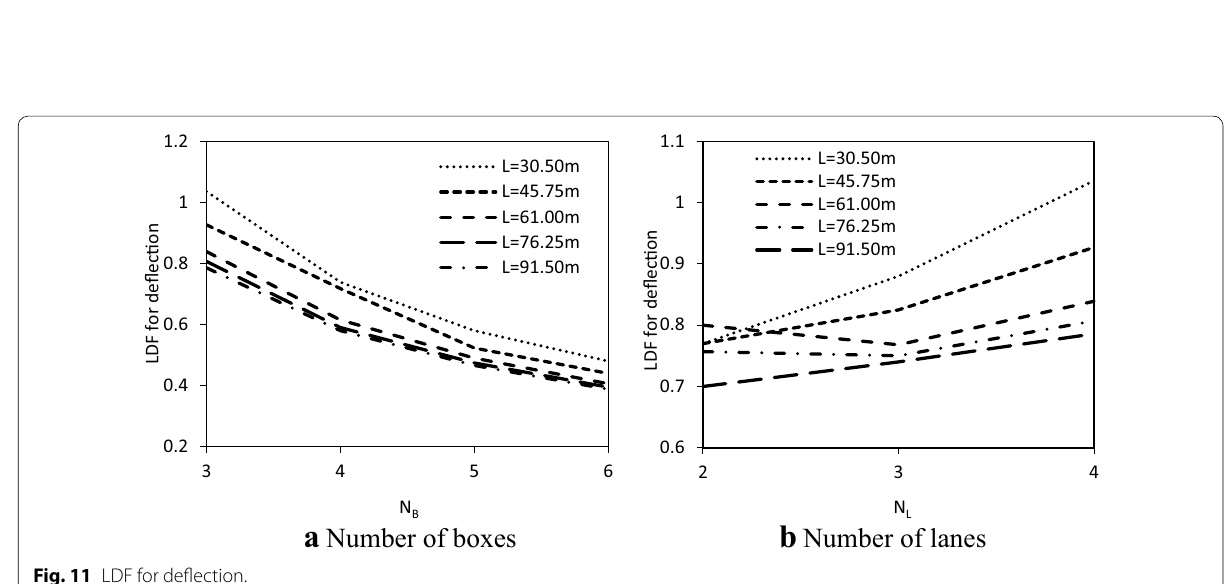
8 Empirical Formulae for the Stresses and the Deflection Samaan et al. (2002a) obtained the following empirical formulas for the maximum positive ( D σ p , sb ) and negative (compression) distributions of stress ( D σ n , sb ) , and for the deflection distribution factor ( D δ s , sb ) for steel spread open box girder bridges: 1.35 × N 0.65 L = N B × L 0.06